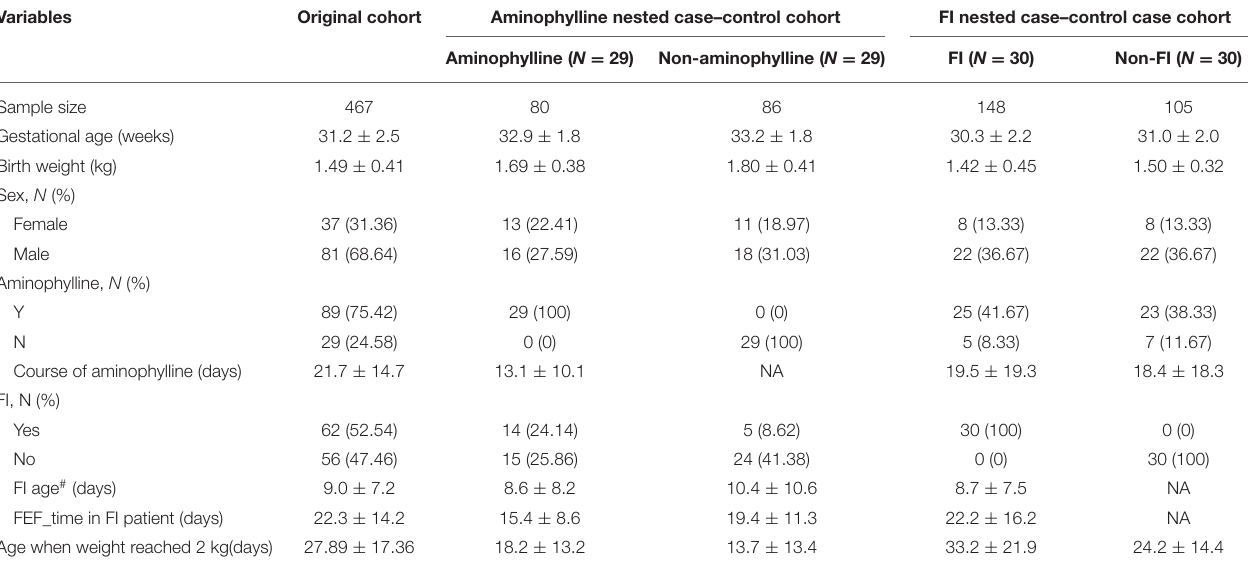
TABLE 1 | Characterization of the cohort. Variables Original cohort Aminophylline nested case–control cohort